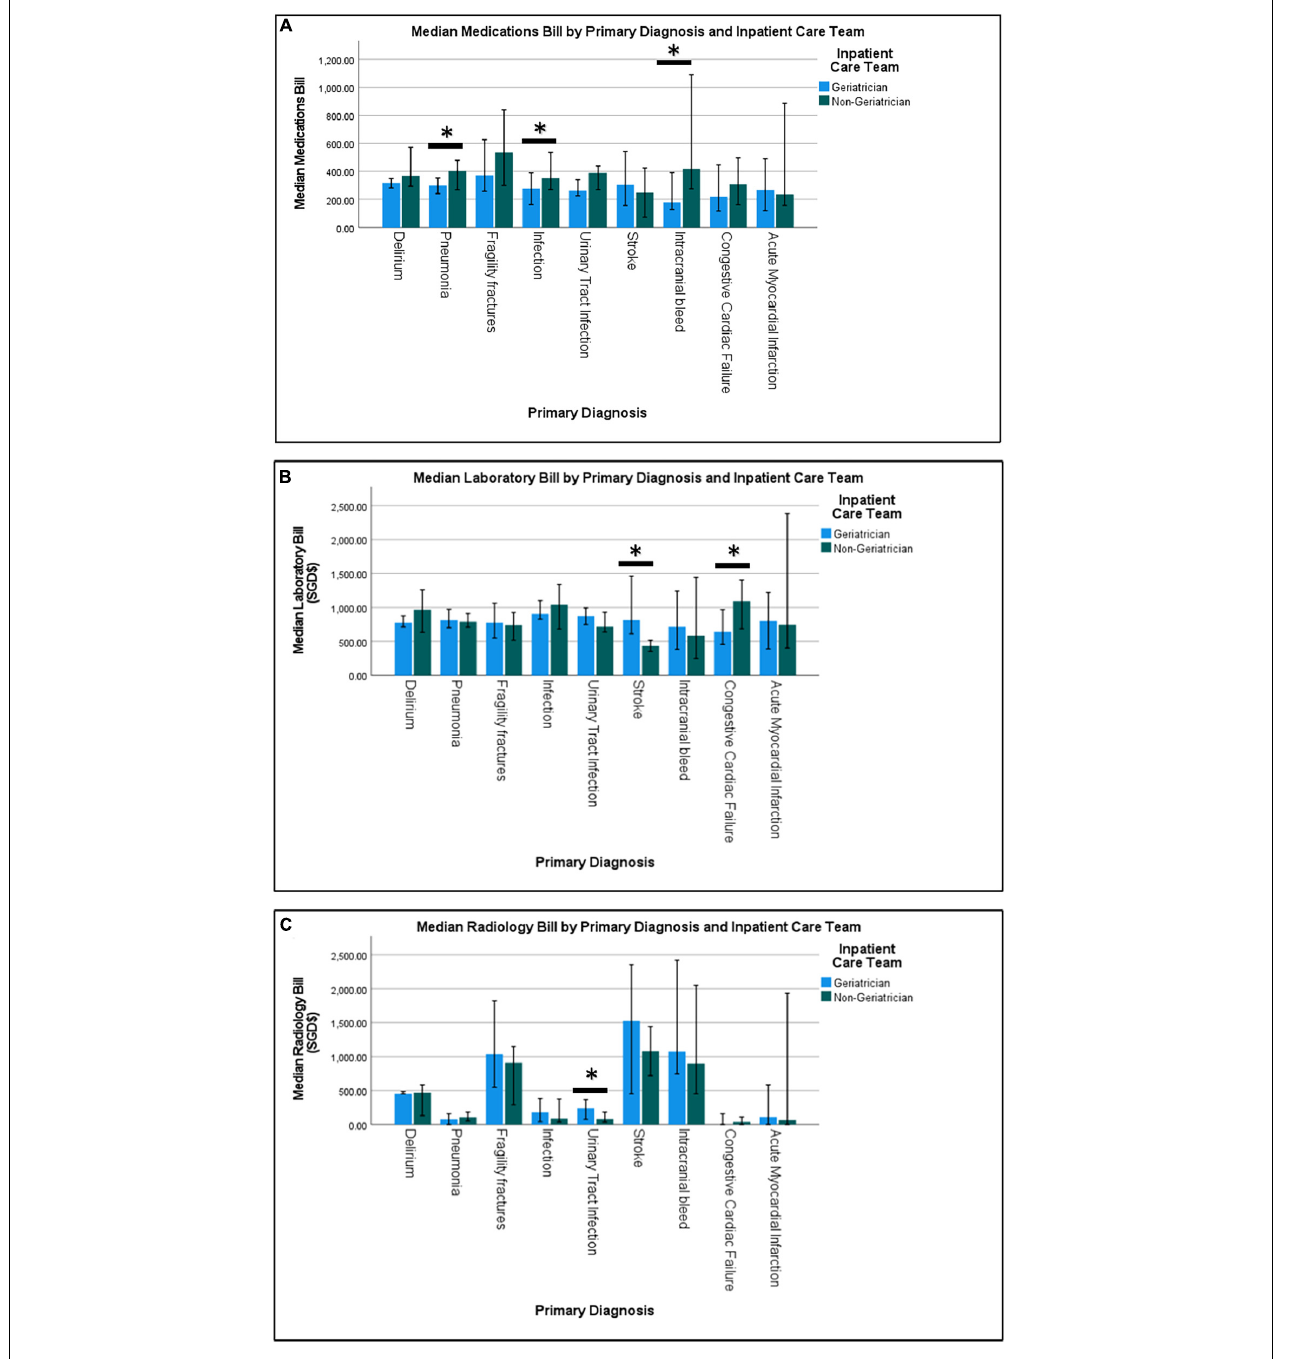
FIGURE 2 | Median medications bill (A) , median laboratory bill (B) and median radiology bill (C) by primary diagnosis and inpatient care team.